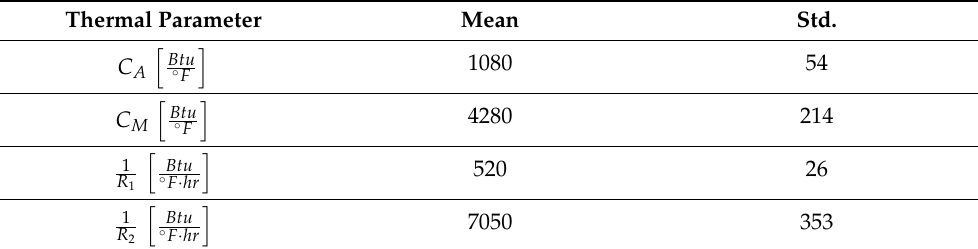
Table A1. Gaussian distribution of thermal parameters.